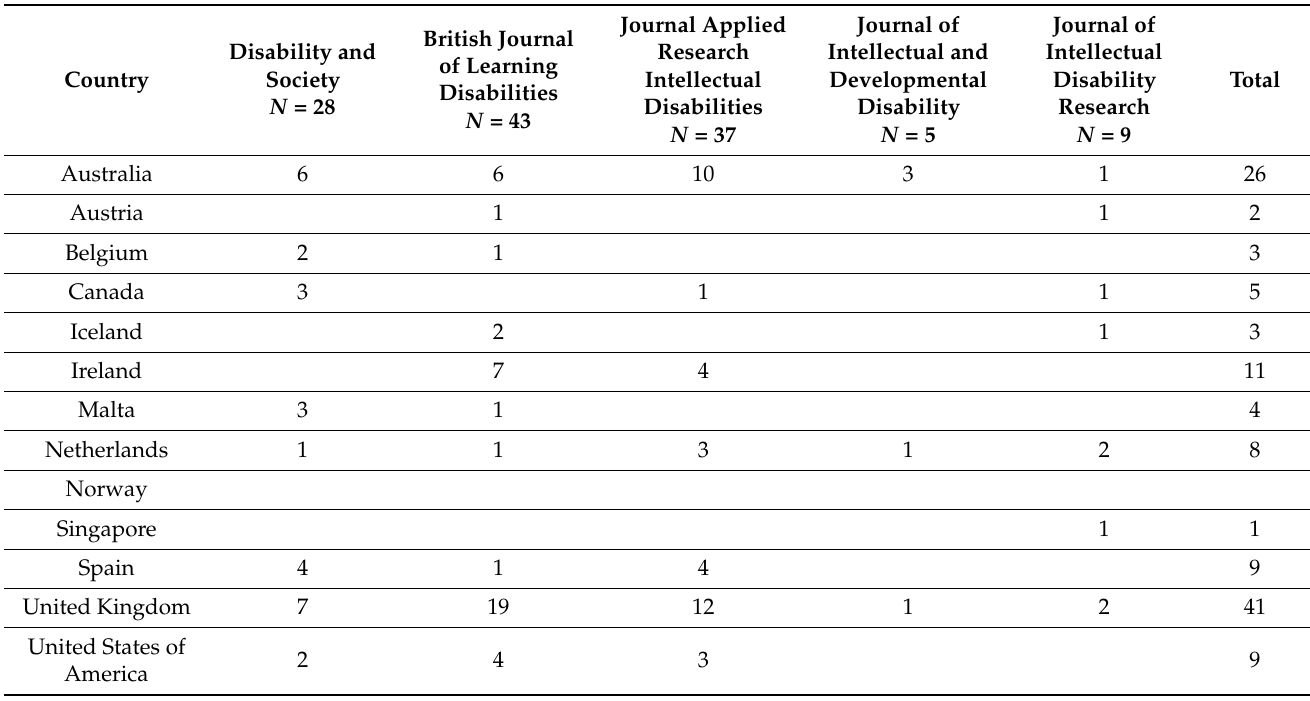
Table 1. Range of countries of authors of articles on inclusive research,